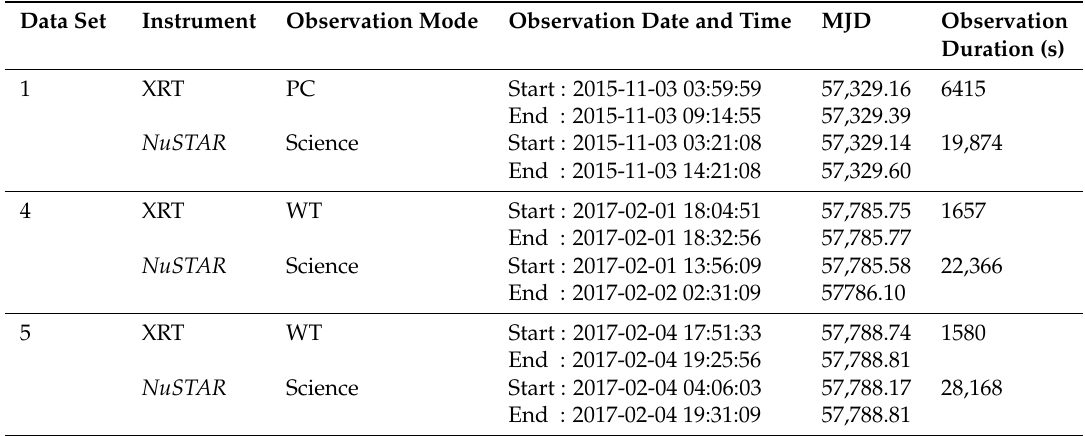
Table 1. Log of X-ray observations of NGC1275. PC: photon counting, WT: widowed timing mode Data